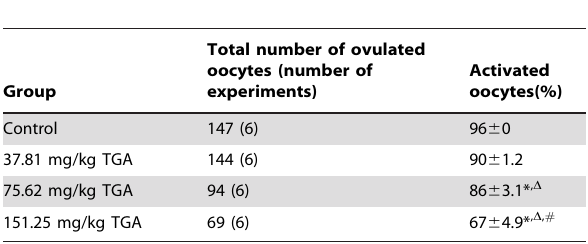
Table 2. Effect of TGA on the parthenogenetic activation of